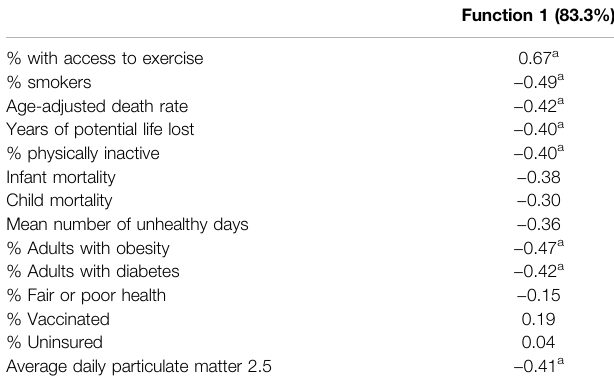
TABLE 6 | Discriminant analysis structure coef fi cients for health outcomes by latent